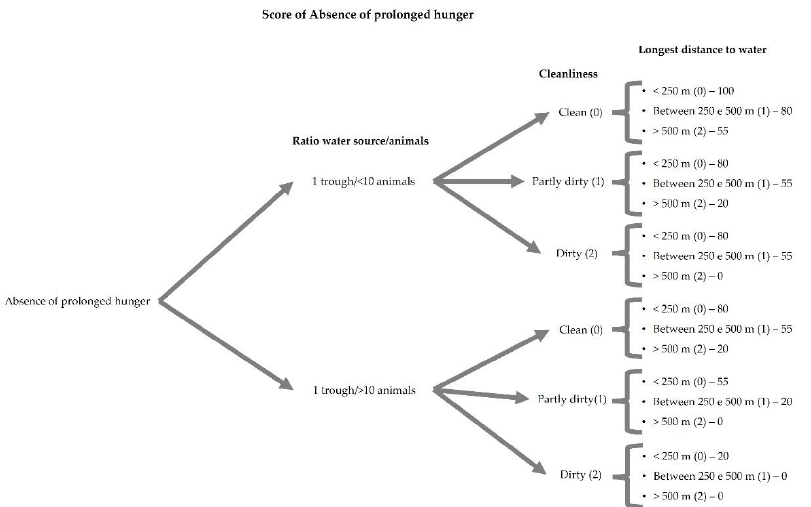
Figure A3. Decision tree for water availability. Having a lagoon or river available was considered as having 1 trough for <10 animals.